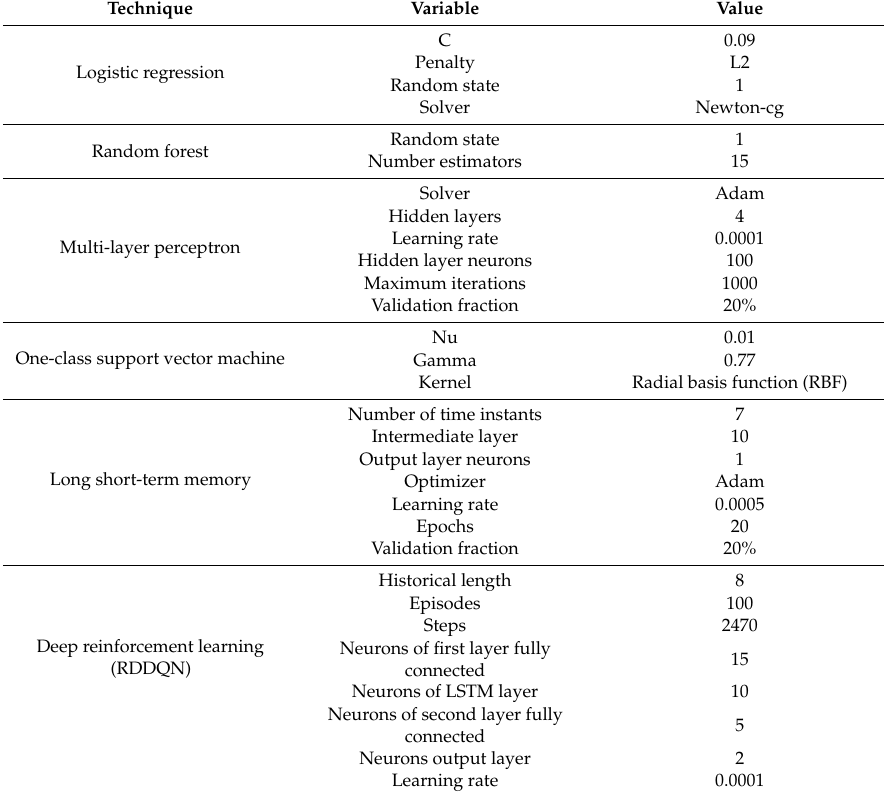
Table 4. Optimized parameters for machine learning (ML) models.